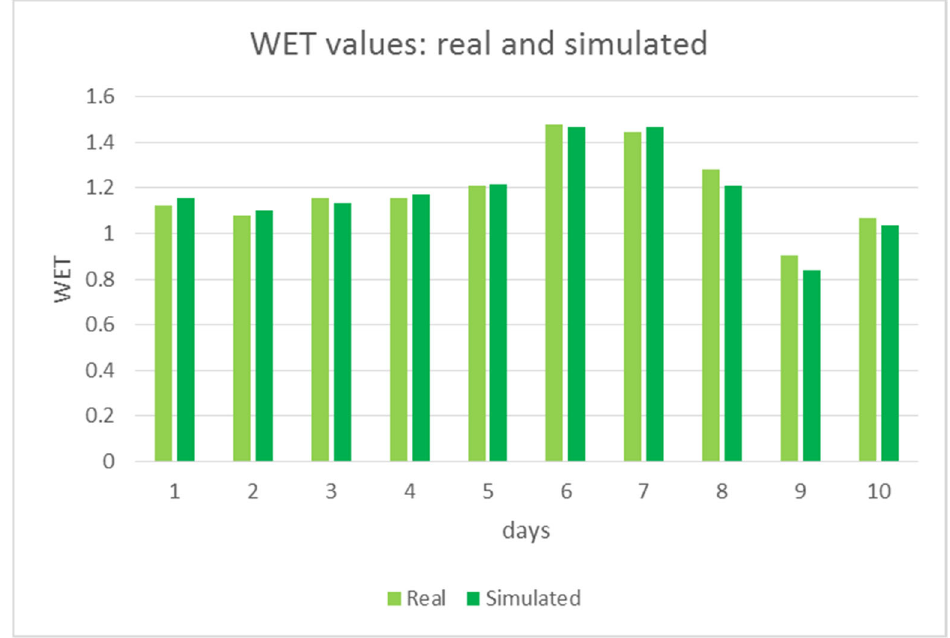
Figure 8. WET indicator: comparison between values coming, respectively, from real and simulated data.